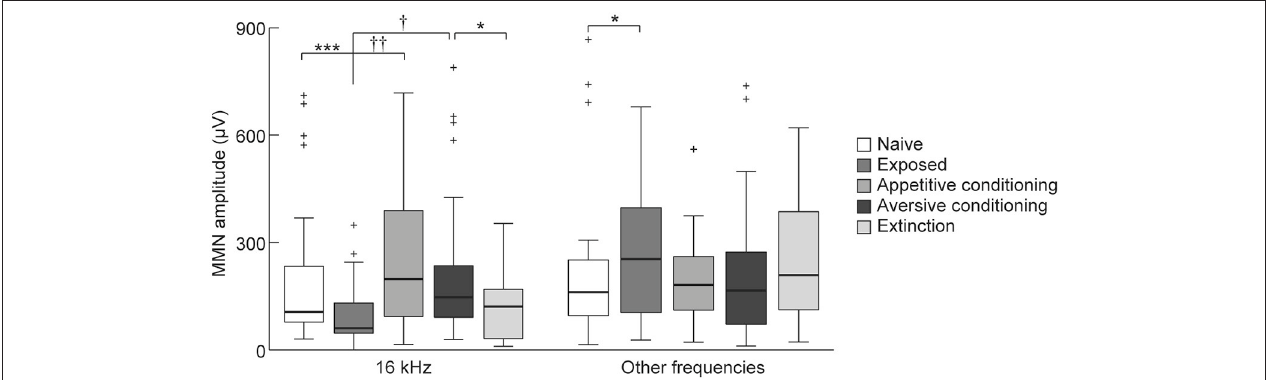
FIGURE 7 | Plasticity of mismatch negativity (MMN) amplitude. MMN amplitude for each animal group ( n = 7 per group × 6 tone pairs). For the exposed group, 16-kHz tone was exposed and for the two conditioning groups and the extinction group, 16-kHz tone was used as the conditioned stimulus (CS).